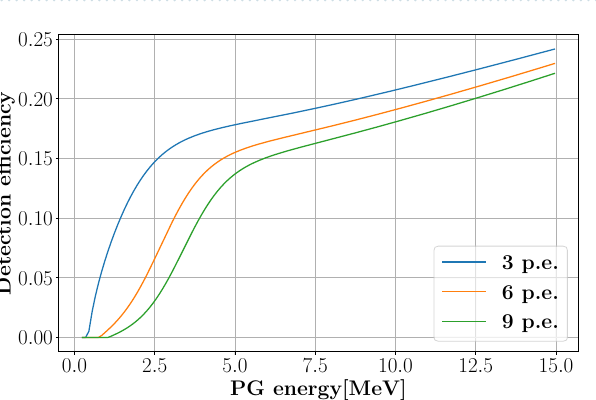
Figure 2. The left plot shows the histogram of the energy deposited in the TIARA module (1 cm 3 PbF 2 crystal coupled to a 3 3 mm 2 SiPM and placed at 90 ◦ respect to the beam) expressed as the integral of the SiPM × signal. PGs are generated by 63 MeV protons impinging on the two PMMA targets described in Fig. 1. The first peak in the histogram corresponds to 6 p.e; the 7, 8, 9 p.e. peaks are also visible: a median number of 7 p.e. per PG were detected. The right plot shows the expected energy spectrum of PGs obtained by MC simulation for comparison. The simulation is performed with the Geant4.10.4.p02 toolkit implementing the QGSP-BIC-EMY physics list and reproducing the PMMA target and beam parameters used in the experiment.